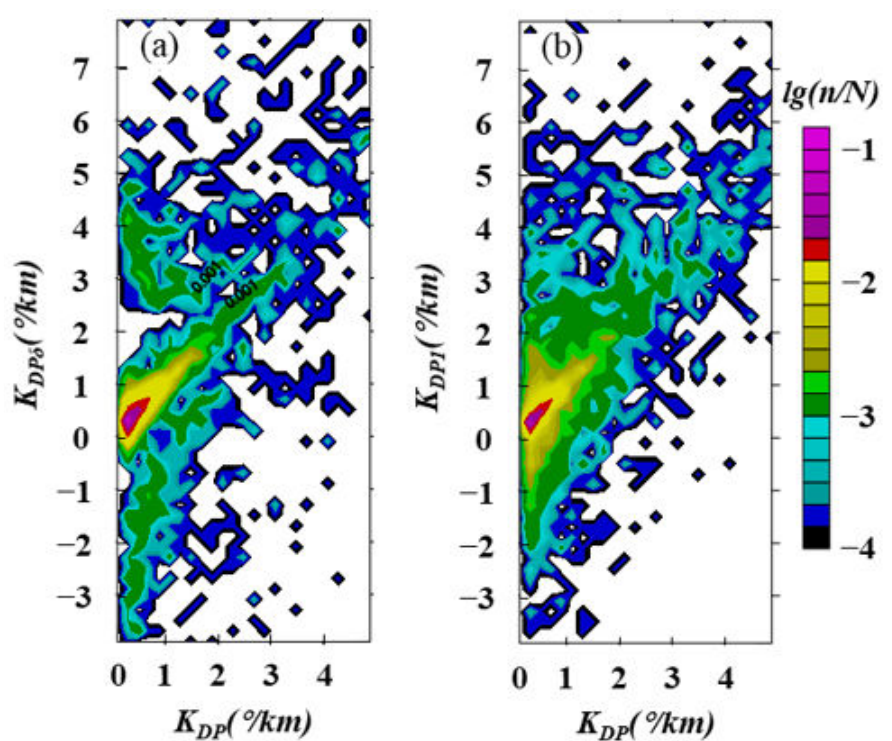
Figure 6. Colored density plot of the simulated K DP versus ( a ) the K DP δ affected by δ and ( b ) the corrected K DP1 based on the δ -elimination using Z DR